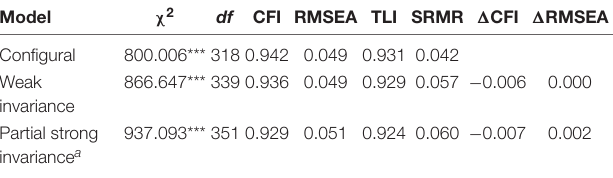
TABLE 4 | Measurement invariance over time in study 2.